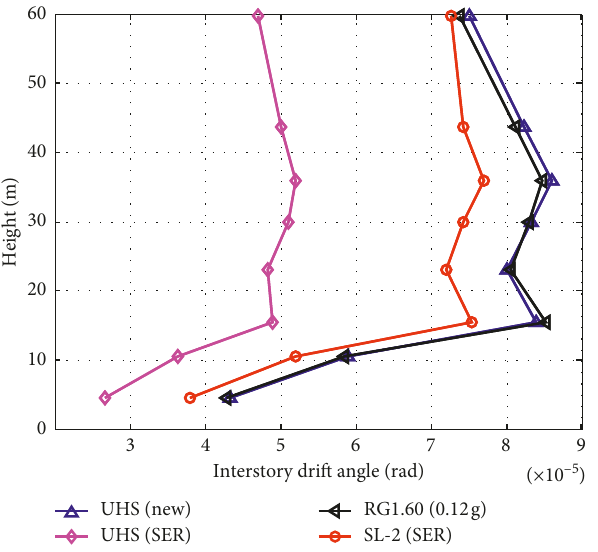
Figure 13: Interlayer drift angle of NPP.